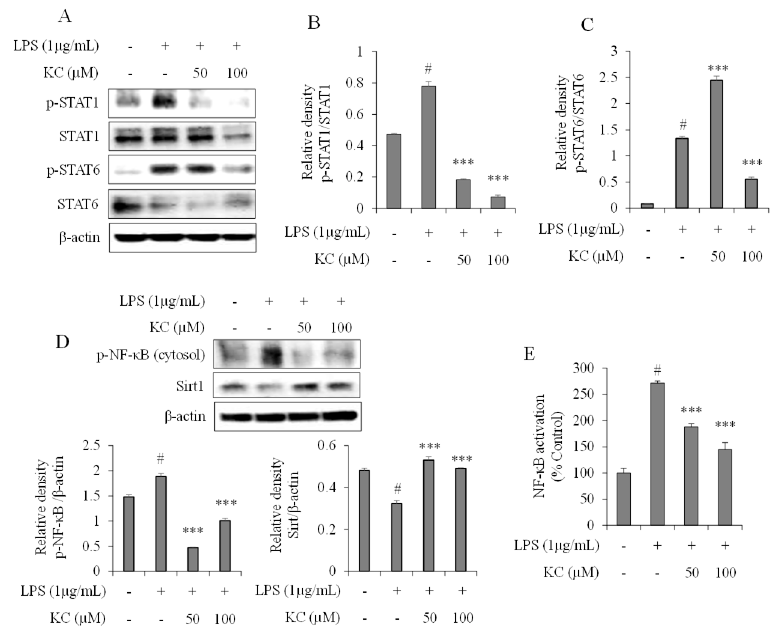
Figure 3. The e ff ects of KC on LPS-induced STAT1 and STAT6 activation ( A – C ), NF- κ B activation ( D ), and NF- κ B-DNA binding activities in RAW264.7 cells. RAW264.7 cells were pretreated with KC (50 or 100 µ M) and stimulated with LPS (1 µ g / mL). The expressions of STAT1, STAT6, p-STAT1, p-STAT6, p-p65, and Sirt1 ( A – D ) were determined by western blot analysis, and the bands developed were analyzed using ImageJ software. DNA binding activity of NF- κ B was measured using an ELISA-based method ( E ). Error bars represent the means ± SDs, # p < 0.001 vs. control, *** p < 0.001 vs. LPS-only treated cells.